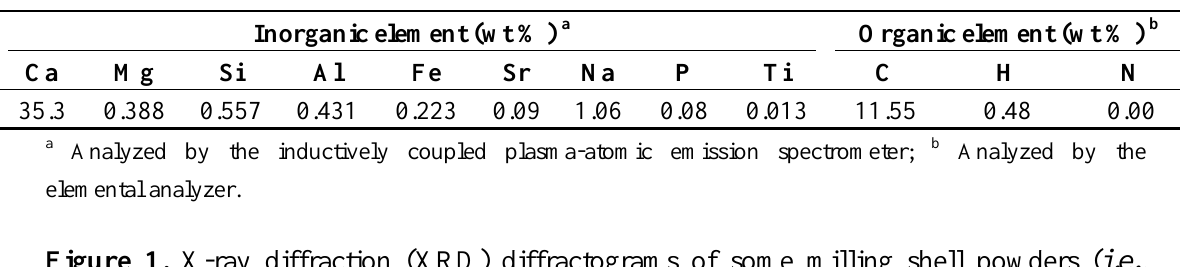
Table 1. Chemical composition of waste oyster shell used as raw material in this work.